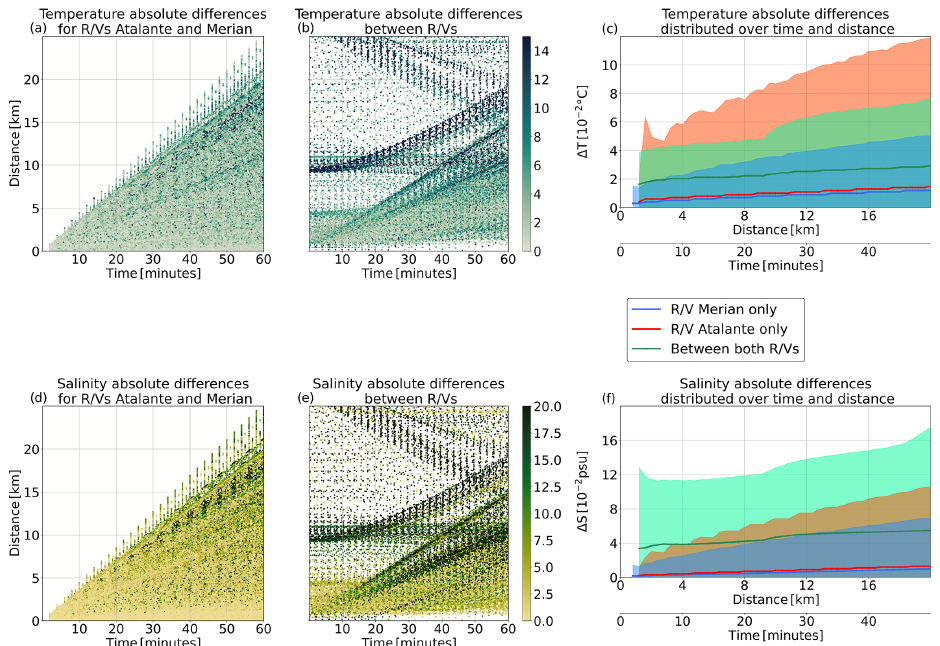
Figure 9. (a) Absolute temperature differences between TSG pairs of measurements distributed in time and distance. Each TSG pair is only composed of measurements from R/Vs L’Atalante or Maria S. Merian . (b) Same as panel (a) but for TSG pairs composed of one measurement from R/V L’Atalante and one from R/V Maria S. Merian . (c) Temperature differences as a function of time and distance for CTD pairs from R/Vs Maria S. Merian (blue) and L’Atalante (red) and composed of one profile of each (green). Panels (d) , (e) , and (f) are same as above but for absolute salinity